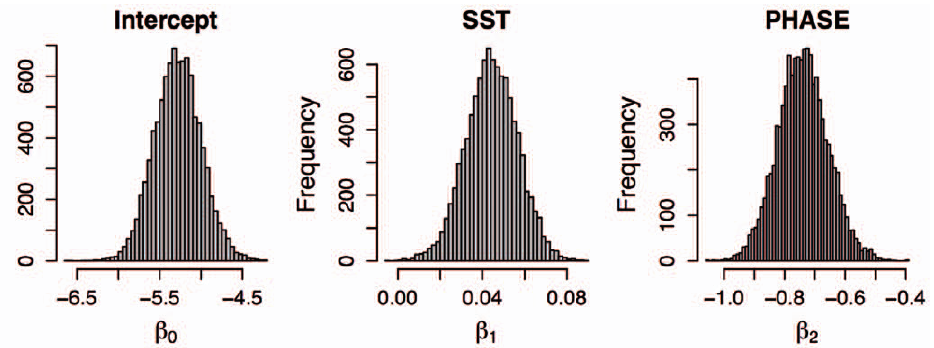
Figure 5. Histograms of MCMC samples depicting the marginal posterior distributions for each of the population-level coefficients.